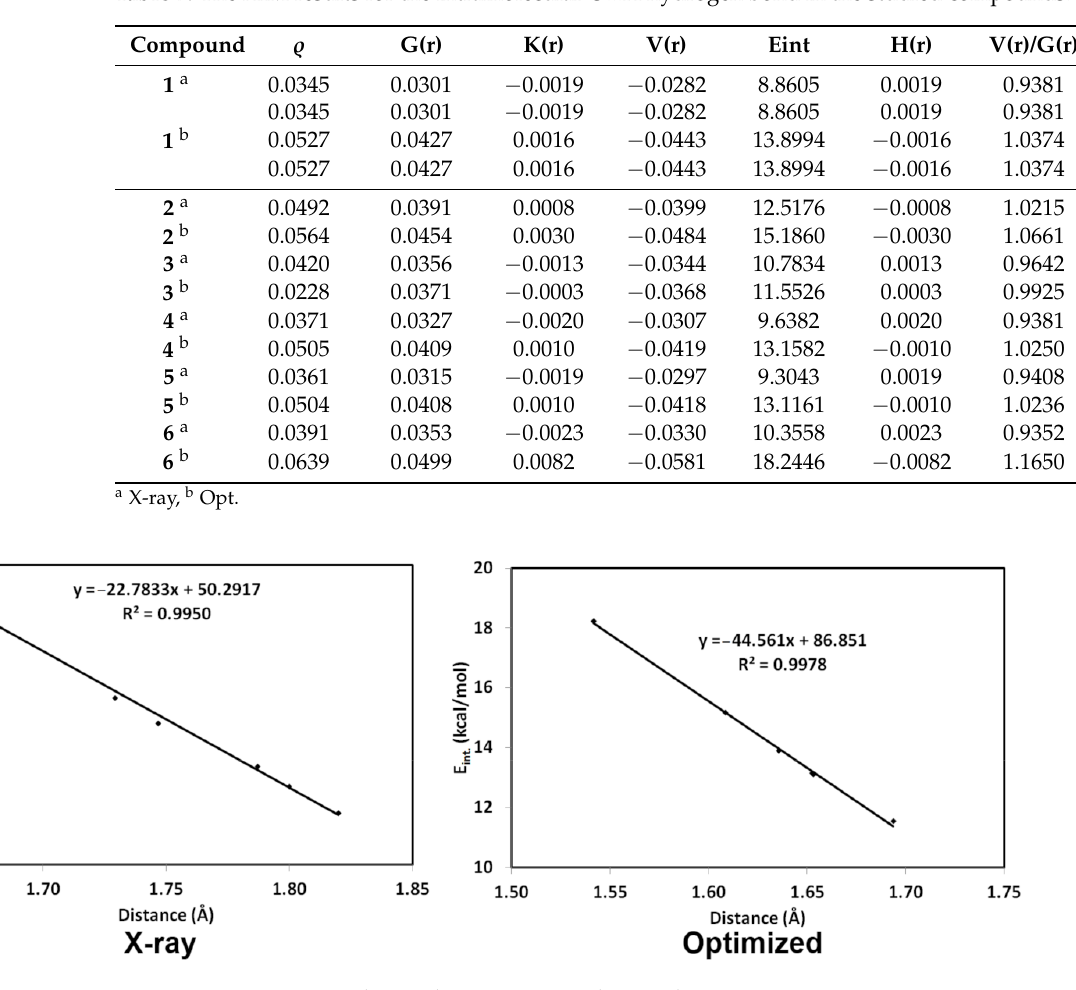
Figure 18. Inverse correlations between E int and A...H